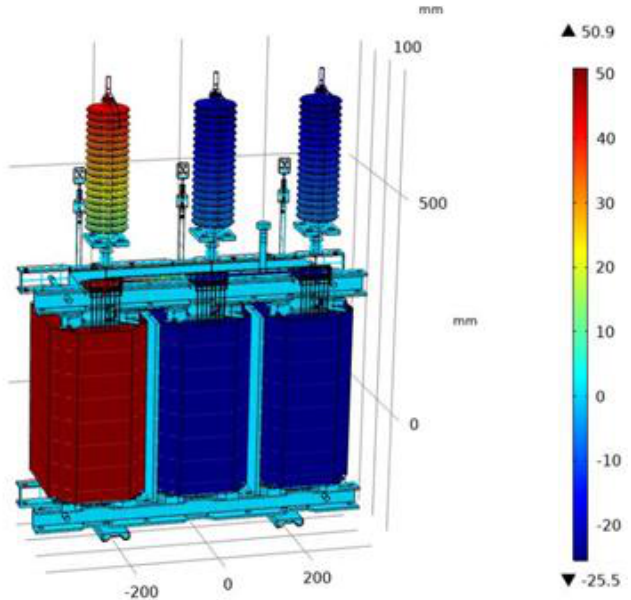
Figure 11. Potential distribution inside the tank in kV